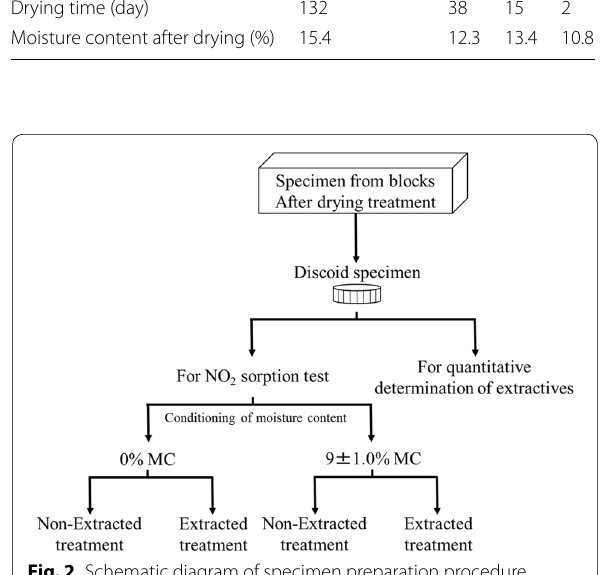
Fig. 2 Schematic diagram of specimen preparation